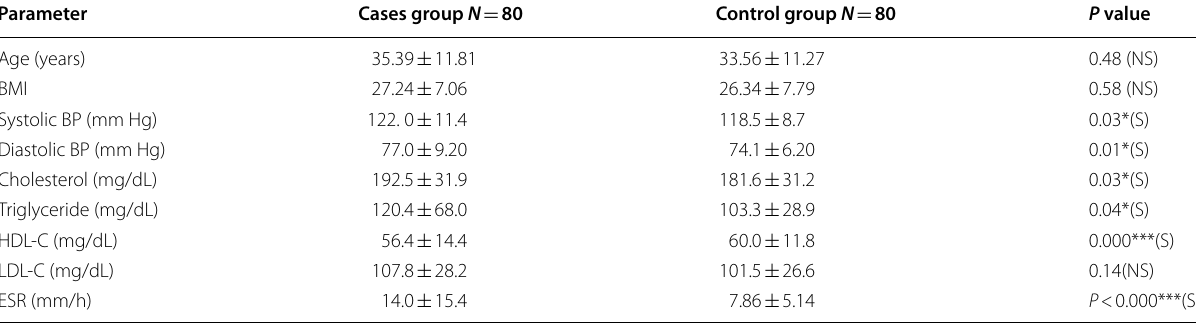
Table 1 Demographic data of studied groups